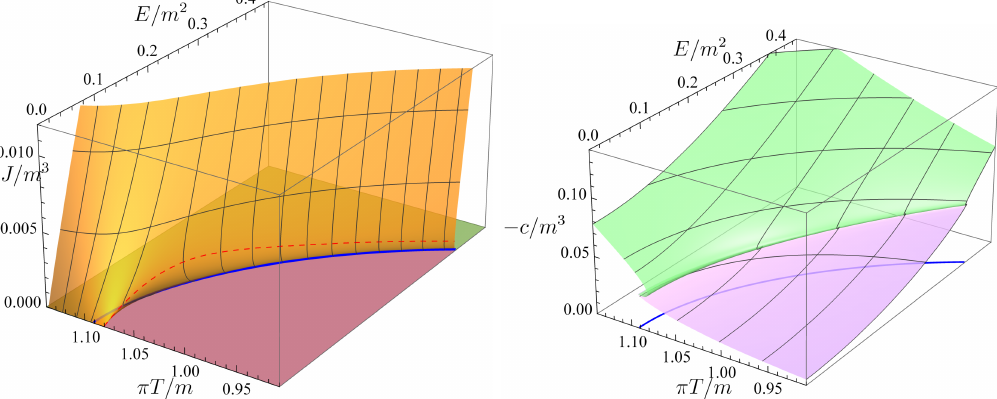
Figure 3 . The left panel shows the plot of J/m 3 with respect to E/m 2 and πT/m near critical temperature in the phase diagram. The purple and green regions denote the Minkowski and black hole embeddings, respectively. The blue curve denotes the critical embedding as shown in figure 2. The vertical black curve shows the E – J curves for each fixed πT/m . The red dashed curve corresponds to the “turning point” of each E – J curve. The right panel shows the plot of − c/m 3 with respect to E/m 2 and πT/m in the same parameter region of the left panel. The purple and green regions again correspond to the Minkowski and black hole embeddings, respectively. We focus on the range of 0 < E/m 2 . 0 . 45 and 0 . 91 . πT/m . 1 . 14